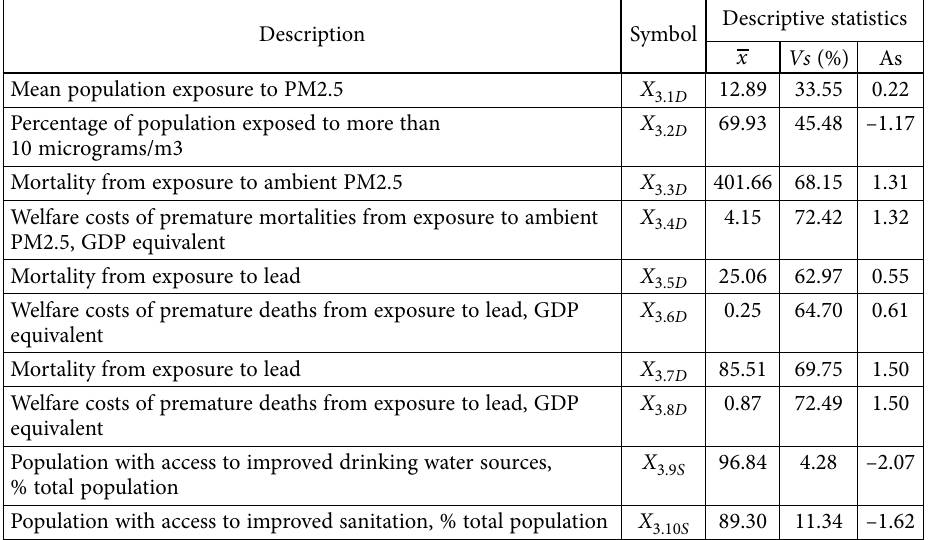
Table 4. Environmental dimensions of quality of life (dimension III)